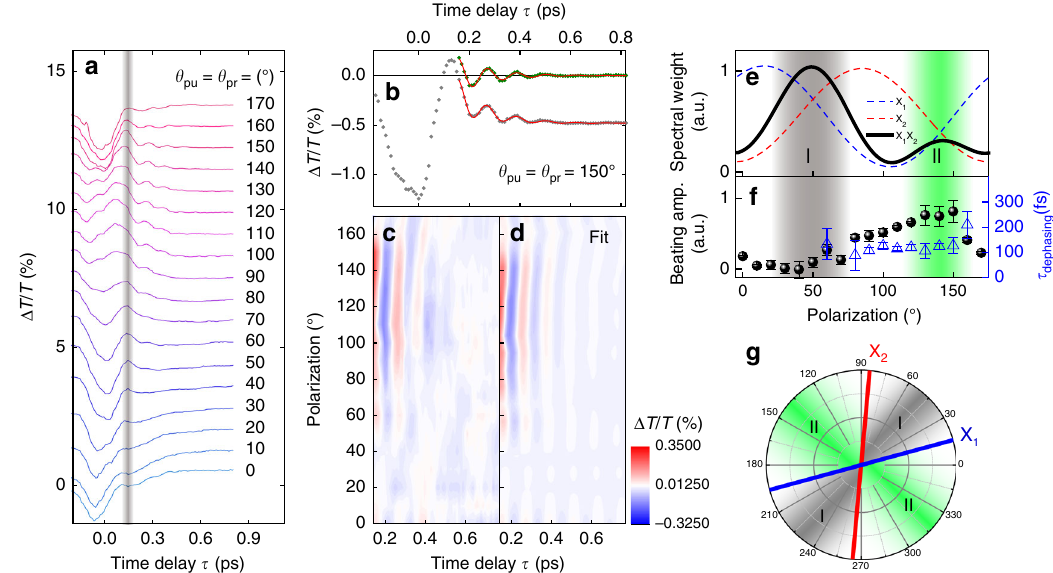
Fig. 3 Polarization-dependent quantum beat of excitons with co-polarized pump-probe. a θ ( = θ pr = θ pu )-resolved DT (offset for clarity). Analyses of the quantum beat are performed on the right side of the vertical gray line. b Original DT trace (gray dots) and its BG-subtracted version (green dots) at θ = 150°. Solid lines are fi ts. c , d Polarization-dependent BG-subtracted DT signals ( c ) and fi ts ( d ). e Dashed lines are spectral weights of X 1 (blue) and X 2 (red), obtained from static absorption in Fig. 2d. The black line is their product. The gray and green areas, indicated by I and II, respectively, are the regions where the theoretical beating amplitude (proportional to the black line in e ) is expected to have local maxima (see main text). f θ -dependent beating amplitude (dots, left axis) and dephasing time constants (triangles, right axis), extracted from the fi ts in d . The error bars represent 95% con fi dence intervals for the fi tting parameters. g A schematic polar diagram illustrating the regions I and II and orientations of the excitons. The blue (red) line indicates the polarization angle at which the spectral weight of X 1 (X 2 ) is maximized